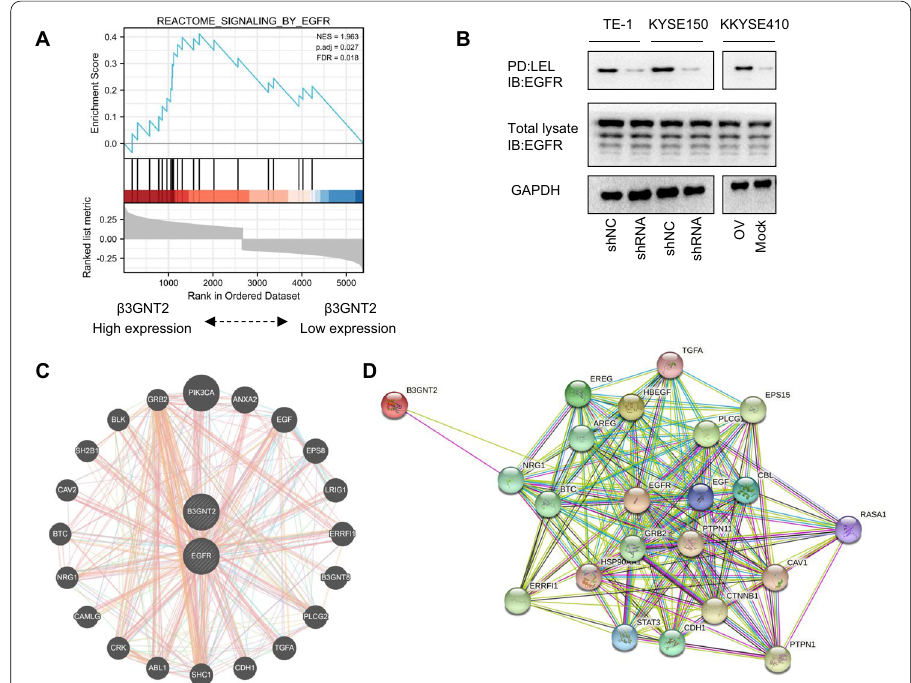
Fig. 5 EGFR can be glycosylated by β3GNT2. A GSEA plot showing a positive correlation between β3GNT2 expression and EGFR signaling. B EGFR pulled down by LEL was analyzed with an anti-EGFR antibody. IB, immunoblot; PD, pull-down. C Protein–protein interaction networks were constructed by the online GeneMANIA tool. D Protein–protein interaction networks were predicted by the String database. Cells were transfected with the indicated plasmids. shNC, negative control shRNA; shRNA, β3GNT2 shRNA2 lentiviral vector; Mock, empty plasmid; OV, pcDNA3.1/β3GNT2